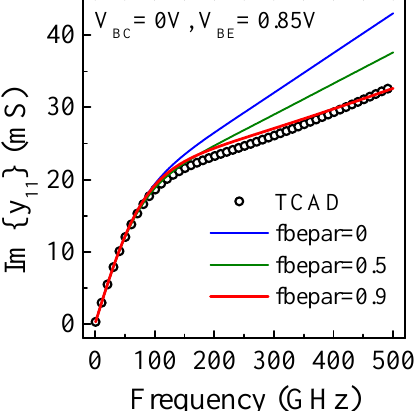
Figure 13. Sensitivity of fbepar on frequency dependent (cid:61) y 11 for the 0.09 µ m × 4.8 µ m SiGe HBT biased at V BC = 0 V with V BE = 0.85 V: comparison between TCAD (circles) and Hicum L2v2.4 (solid